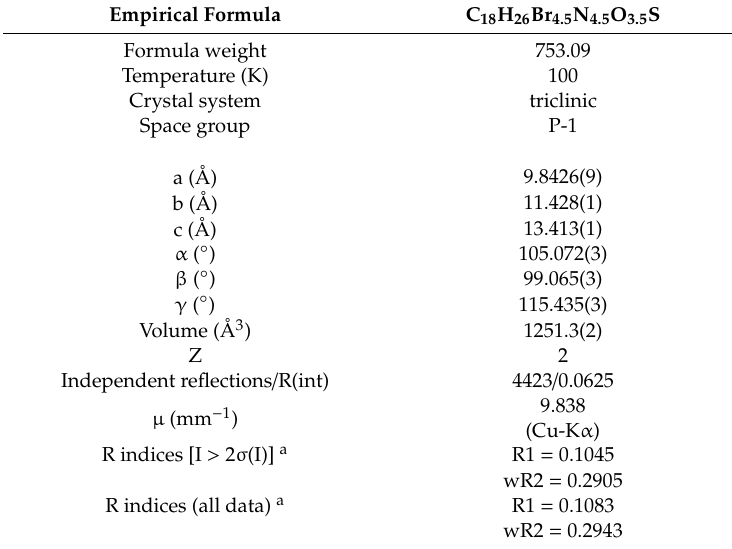
Table 2. Crystal data and refinement parameters for (H 2 L-Ts)(Br 3 ) 1.5 (NO 3 ) 0.5 ( 1